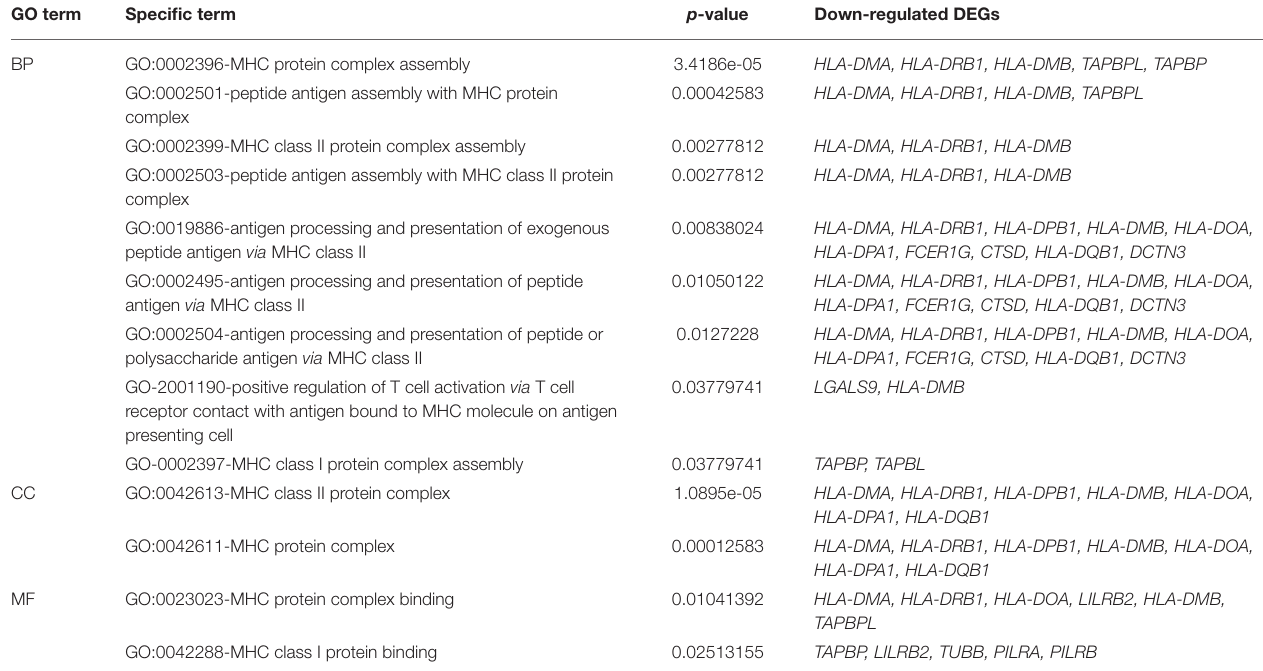
TABLE 2 | Gene Ontology (GO) terms associated with the major histocompatibility complex (MHC) protein complex in downregulated differentially expressed genes (DEGs). GO